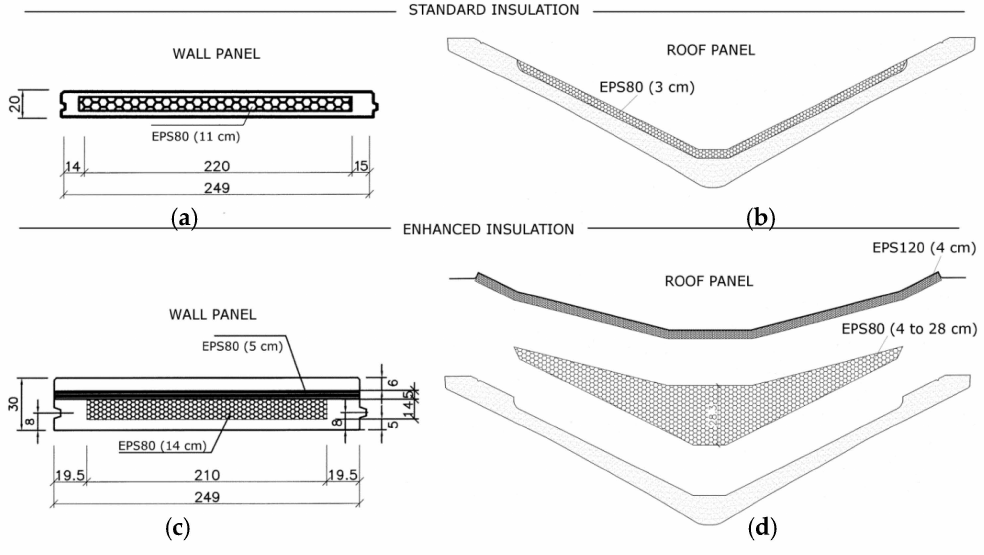
Figure 1. Top-view section of the wall panels ( a,c ) and front-view section of the roof panels ( b,d ) for standard insulation ( a , b ) and enhanced insulation ( c , d